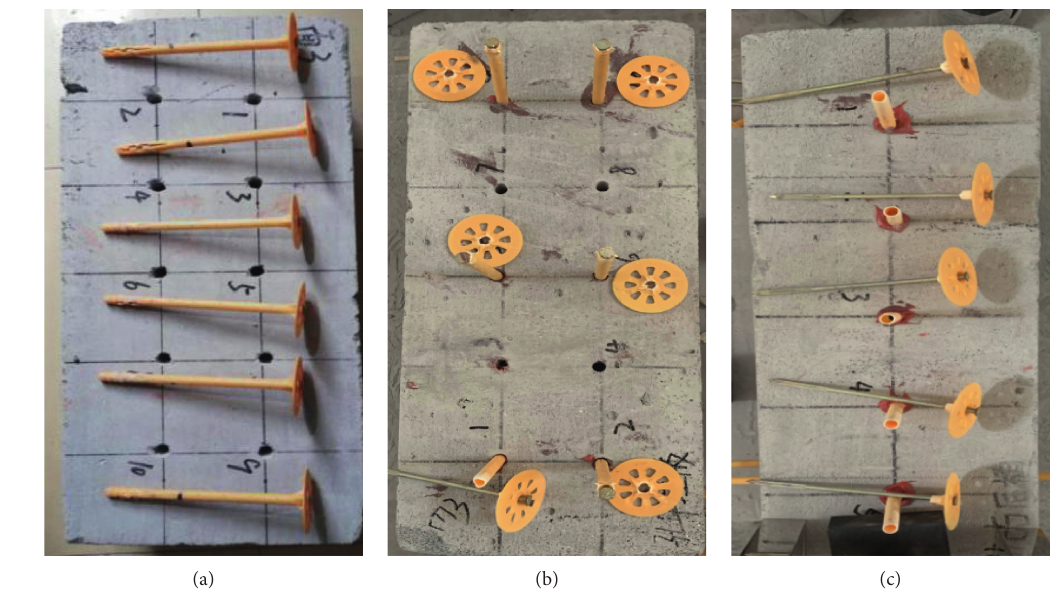
Figure 7: Anchor bolt pull-out strength test results. Table 1: Pull-out strength test data of different anchorage